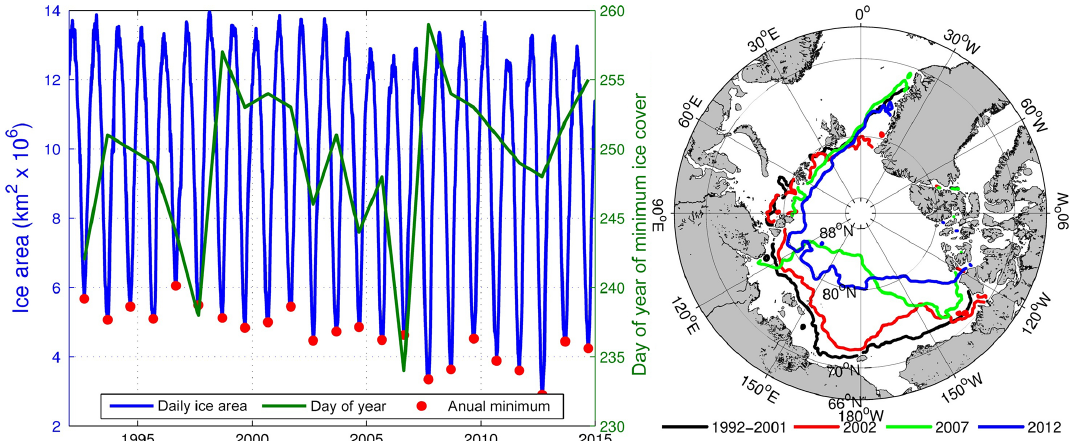
Figure 2. SSM/I Ifremer CERSAT ice concentrations 1992–2014. The left panel displays the ice coverage in the area, assuming for grid points with a concentration greater than 15% (blue) and minimum of the day of the year (green). The right panel shows the minimum spatial ice edge defined by the 15% ice concentration contour for 1992–2001 (median), 2002, 2007, and 2012.